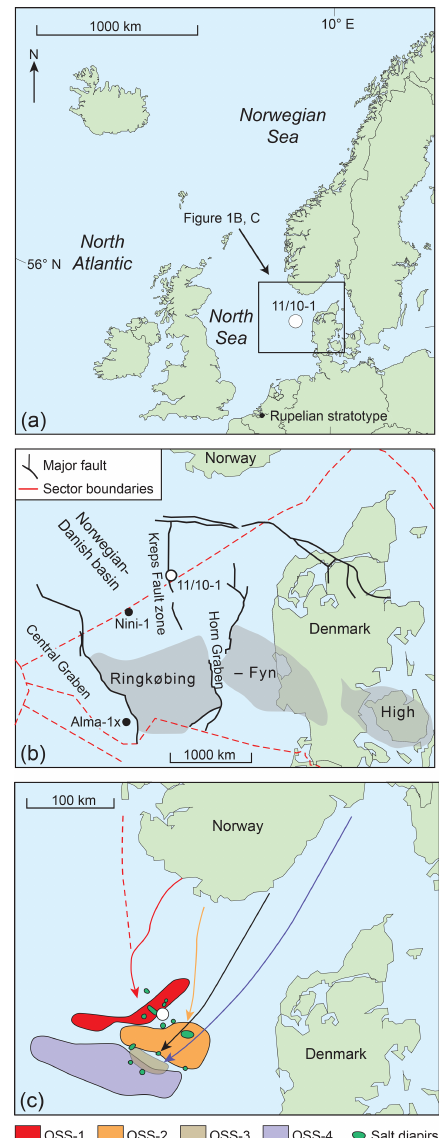
Figure 1. (a) The North Sea basin is located on the eastern flank of the North Atlantic Ocean. The black star marks the location of the Rupelian stratotype (Van Simaeys and Vandenberghe, 2006). (b) The 11/10-1 well was drilled close to the border between the Norwegian and the Danish North Sea sectors. Black dots mark the location of two other wells from the North Sea basin which penetrate Oligocene rocks Alma-1X (Schiøler, 2005) and Nini- 1 (Clausen et al., 2012; ´Sliwi´nska et al., 2010; ´Sliwi´nska and Heilmann-Clausen, 2011). (c) The sediment transport direction and the position of the Oligocene depocentres are after Danielsen et al. (1997) and Jarsve et al. (2015). OSS-1 to OSS-4 stand for names of local Oligocene seismic sequences sensu Jarsve et al. (2015). The map shows the distribution of the depocentres for each of the OSS sequence; (a) , (b) and (c) are modified from ´ Sliwi´nska and Heilmann-Clausen (2011), ´ Sliwi´nska et al. (2010), and Jarsve et al. (2015),